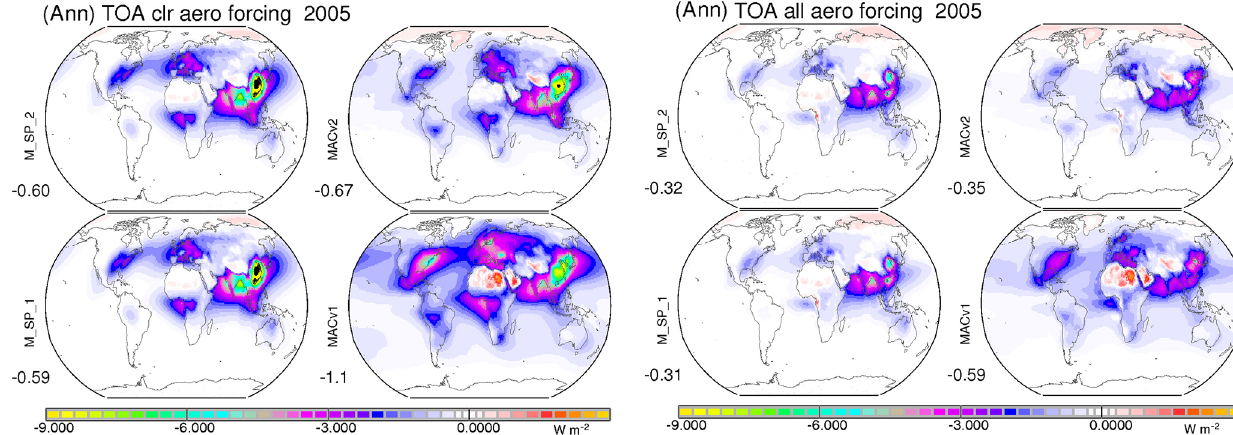
Figure B1. Annual maps for present-day aerosol direct radiative forcing in watts per square meter (Wm − 2 ) at the TOA for clear-sky conditions (left frame) and for all-sky conditions (right frame) for MACv2-SP with MACv1 natural background (upper left) and with MACv2 natural background (lower left), for MACv2 (upper right) and MACv1 (lower right). Blue colors represent climate cooling and red colors indicate climate warming. Values below the labels indicate global